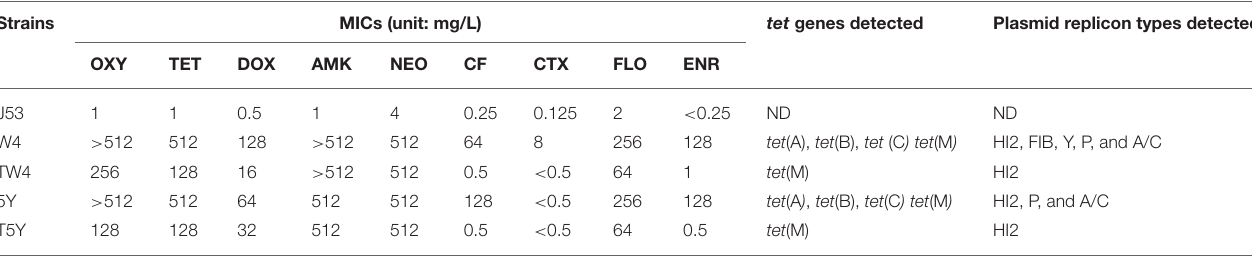
TABLE 3 | Characteristics of strains used in conjugation experiments. Strains MICs (unit: mg/L) tet genes